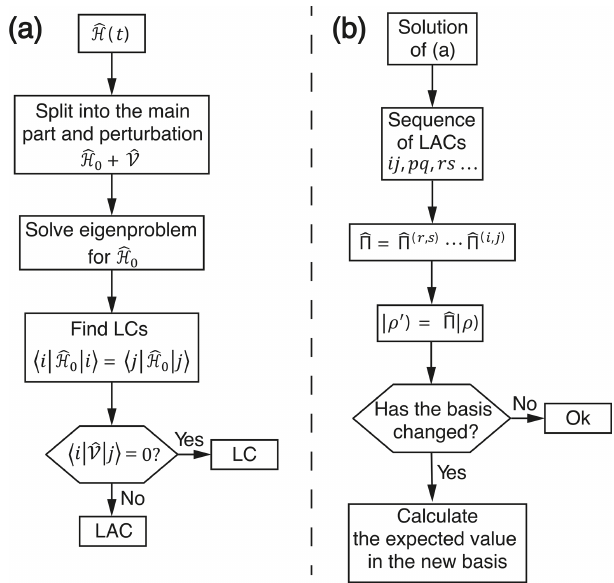
Figure 9. Flowchart diagram indicating (a) the way to find all LACs and (b) to calculate the spin dynamics due to